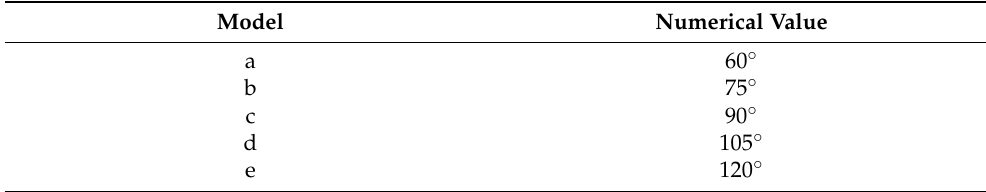
Table 4. Simulation parameters of different contact angles.